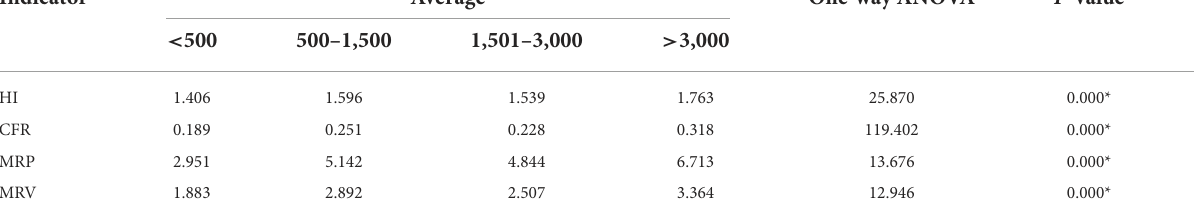
TABLE 2 One-way ANOVA results.